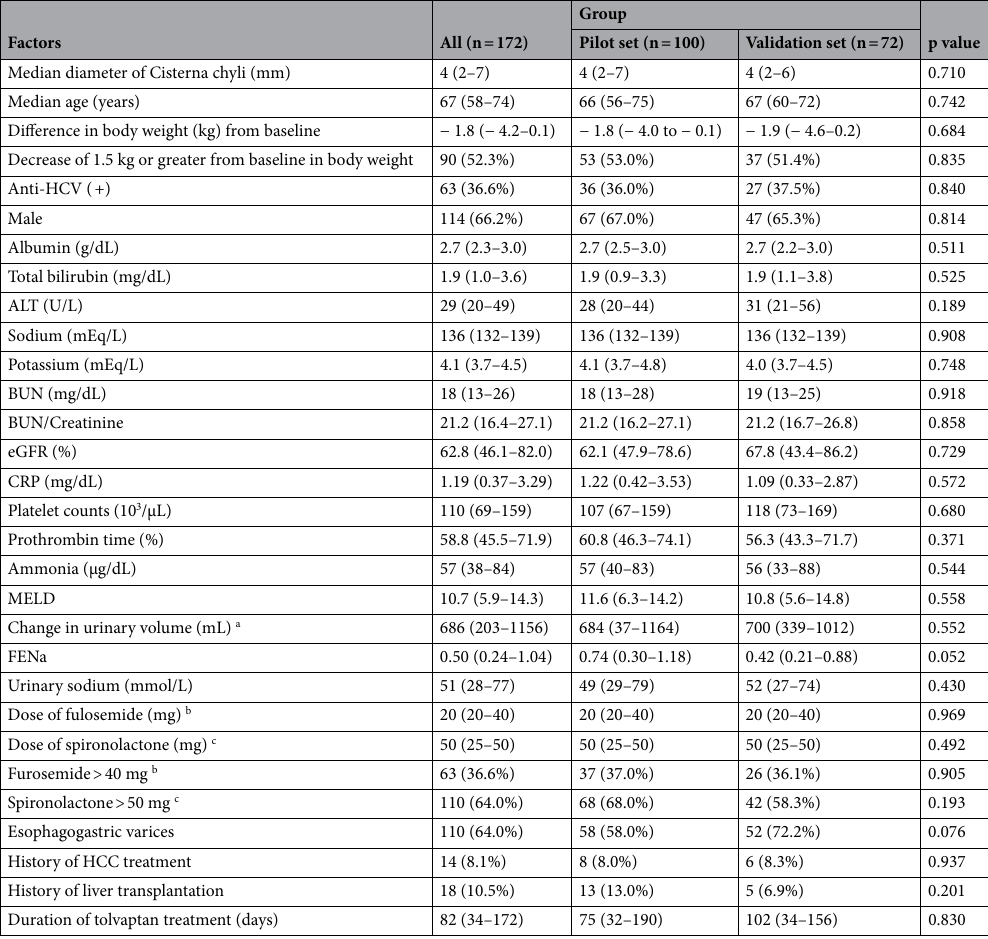
Table 1. Patient characteristics. HCV hepatitis C virus, ALT alanine aminotransferase, BUN blood urea nitrogen, eGFR estimated glomerular filtration rate, CRP c-reactive protein, MELD model for end-stage liver disease, FENa fractional excretion of sodium: (urine sodium/serum sodium)/(urine creatinine/serum creatinine), HCC hepatocellular carcinoma. a Difference in 24-h urine volume before and after tolvaptan treatment. b Dose of furosemide during tolvaptan treatment. c Dose of spironolactone during tolvaptan